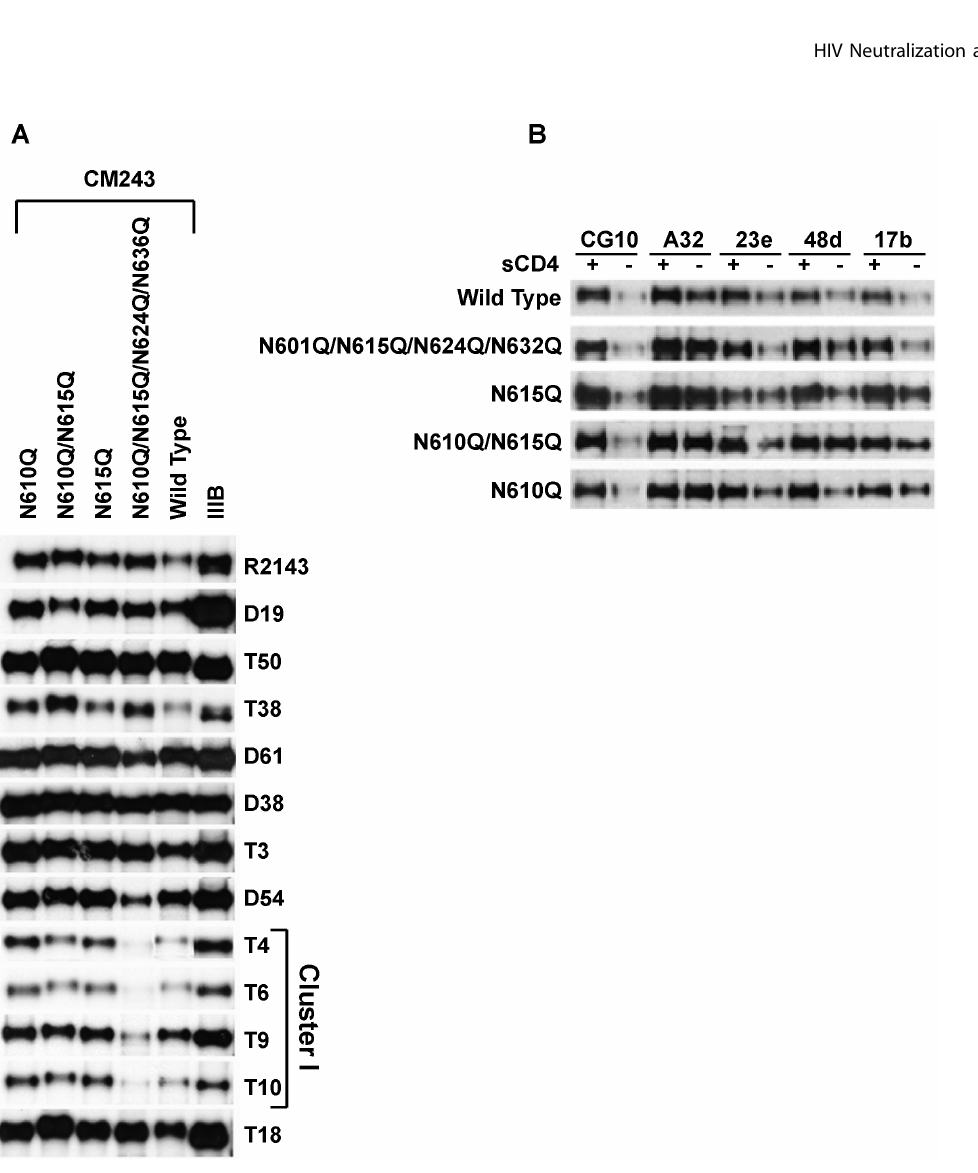
Figure 2. Monoclonal antibody and CD4 binding of the deglycosylation mutants of HIV-1 strain CM243 gp140 Envs. A. Reactivity of CM243 gp140 wild type and glycosylation mutants to a panel of conformation-dependent and -independent monoclonal antibodies by immunoprecipitation and reduced SDS-PAGE analysis of metabolically labeled gp140s and autoradiography. While equivalent reactivities with mAbs D19, T50, D38, and T3 were seen in both wild type and mutant gp140 s, differential reactivities were found with mAbs that map to the Cluster I region in gp41. These are conformation dependent, oligomeric specific anti-gp41 antibodies. B. Analysis of mAb binding to CD4i epitopes following sCD4 binding to purified gp140 proteins by immunoprecipitaion and SDS-PAGE and western blot detection using rabbit polyclonal antisera. homologous neutralization that was significantly different by paired T test (p = 0.009). In comparisons between the groups, the R2 pseudotyped virus was neutralized by all sera from those monkeys immunized with the R2 Env, but by serum from only one monkey immunized with 14/00/4 at dilutions $ 1:20, a difference that was significant by T test (p =0.008). In contrast, the 14/00/4 Env pseudotyped virus was neutralized by 5/6 sera from monkeys immunized with R2 Env as well as all animals immunized with 14/00/4 Env at dilutions $ 1:20, a difference that was not significant by T test (p= 0.11). Only two sera from the R2 group and one from the 14/00/4 group neutralized CM243(N610Q) virus at dilutions of 1:20. Neutralization of R2 and 14/00/4 Env pseudtyped viruses by sera from Group IV monkeys (Trivalent immunization group) was comparable. The homologous neutral- ization results confirmed the somewhat greater breadth of response induced by R2 Env as compared to the 14/00/4 Env